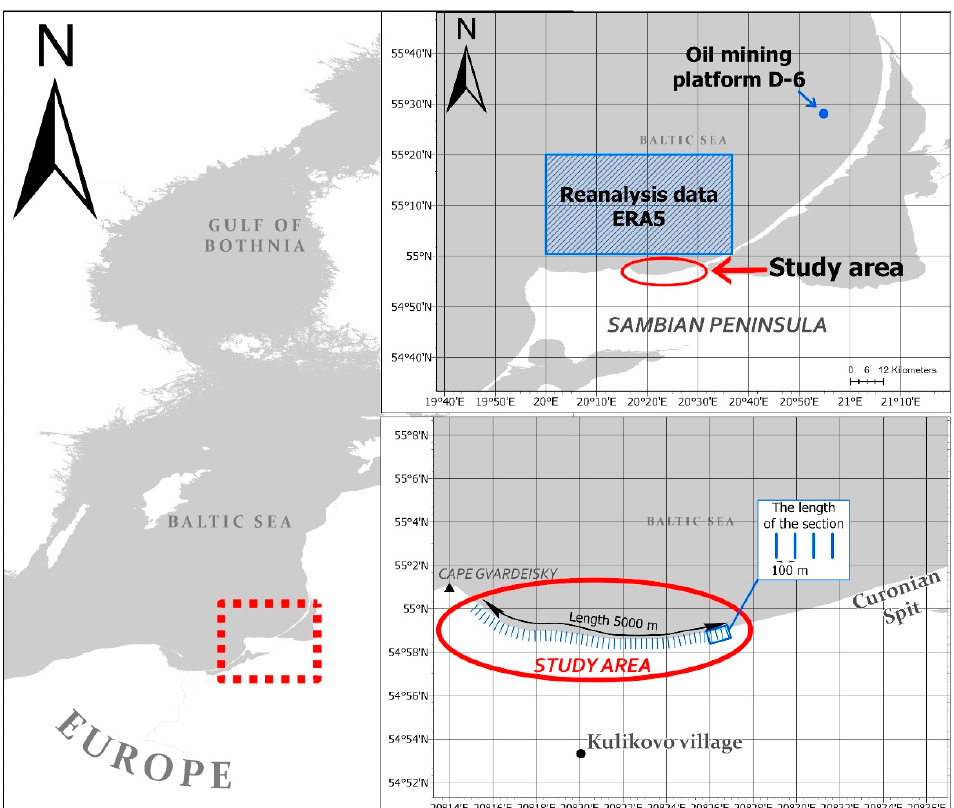
Figure 3. Study area in southeastern part of the Baltic Sea. Table 1. Parameters of meteorological and hydrophysical conditions at 12:00 local time (GMT + 2) for each observation.